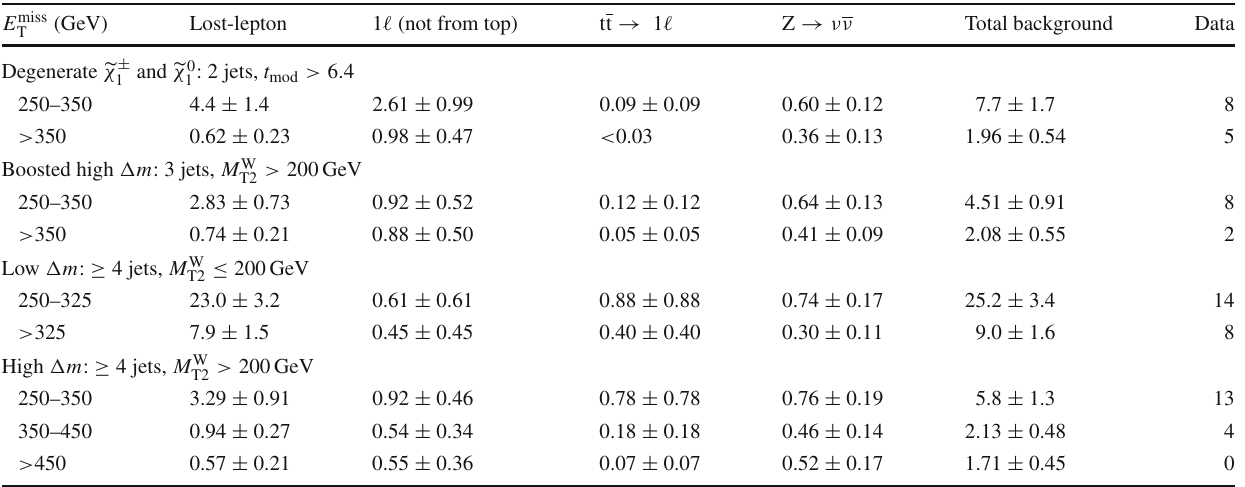
Table 4 Background estimates from data and simulation, and observed data yields for the single-lepton top squark analysis using 2.3fb − 1 of data collected during 2015 pp collisions. The uncertainties are the quadratic sums of statistical and systematic uncertainties